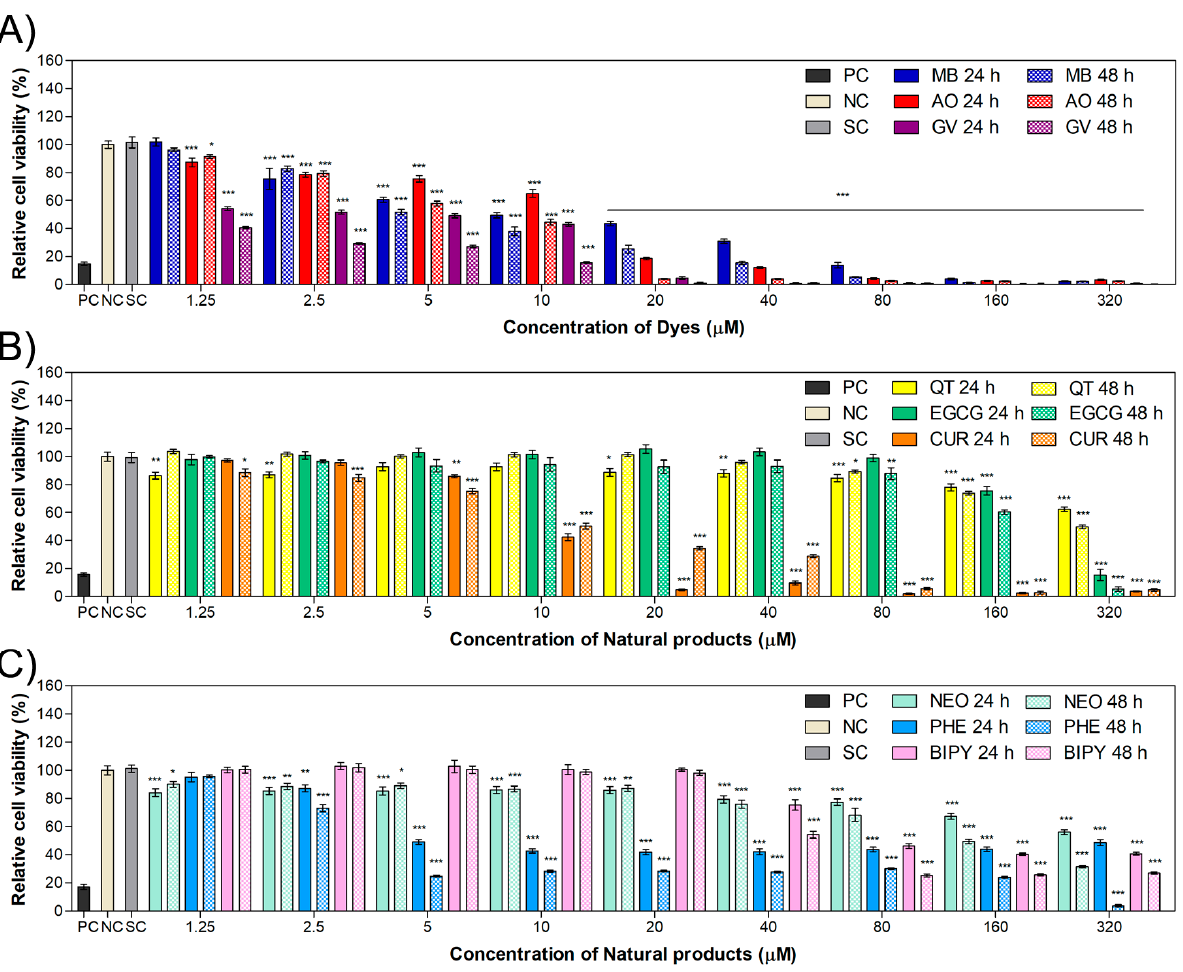
Figure 1. Cell viability of HaCaT cells treated for 24 or 48 h with ( A ) dyes (MB, AO and GV), ( B ) natural compounds (QT, CUR and EGCG) or ( C ) chelating molecules (NEO, PHE and BIPY) with a range of concentration from 1.25 µM to 320 µM. Values are presented as the mean ± combined standard uncertainty ( n = 4), and statistical analysis comparing the results to the cell viability of the negative control was performed by a two-way ANOVA with Bonferroni post test, where * p < 0.05, ** p < 0.01 and *** p < 0.001. MB: methylene blue, AO: acridine orange, GV: gentian violet, QT: quercetin, EGCG: epigallocatechin gallate, CUR: curcumin, NEO: neocuproine, PHE: 1,10-phenanthroline, BIPY: 2,2 ′ -bipyridyl, PC: positive control, NC: negative control, SC: solvent control.